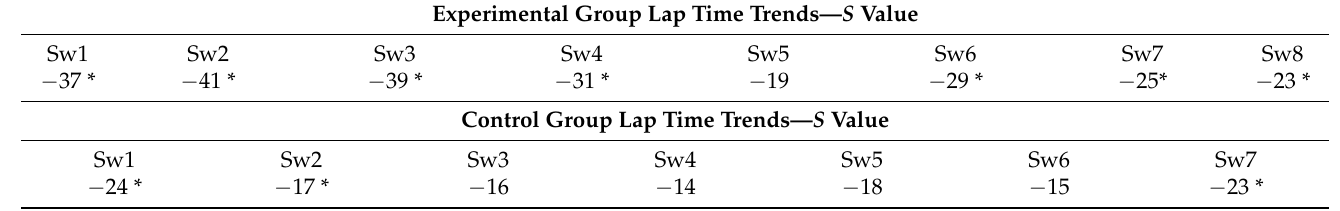
Table 2. Person-level comparison between the experimental group and the control group. S value for the Mann-Kendall trend test of average lap time values during 10 training sessions. A negative sign indicates a decreasing trend.